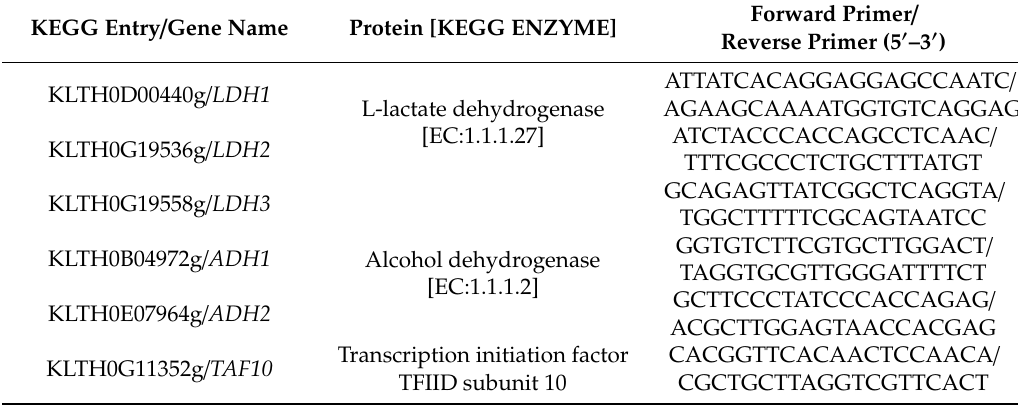
Table 1. Genes and primers used for quantitative RT-PCR analysis. KEGG GENES database is available at http: // www.genome.jp / kegg / genes.htmL (Kyoto University Bioinformatics Center, Kyoto, Japan). Forward Primer / KEGG Entry / Gene Name Protein [KEGG ENZYME] Reverse Primer (5 (cid:48) –3 (cid:48) ) ATTATCACAGGAGGAGCCAATC / KLTH0D00440g / LDH1 AGAAGCAAAATGGTGTCAGGAG L-lactate dehydrogenase ATCTACCCACCAGCCTCAAC / [EC:1.1.1.27] KLTH0G19536g / LDH2 TTTCGCCCTCTGCTTTATGT GCAGAGTTATCGGCTCAGGTA / KLTH0G19558g / LDH3 TGGCTTTTTCGCAGTAATCC GGTGTCTTCGTGCTTGGACT / KLTH0B04972g / ADH1 Alcohol dehydrogenase TAGGTGCGTTGGGATTTTCT [EC:1.1.1.2] GCTTCCCTATCCCACCAGAG / KLTH0E07964g / ADH2 ACGCTTGGAGTAACCACGAG Transcription initiation factor CACGGTTCACAACTCCAACA KLTH0G11352g / TAF10 TFIID subunit 10